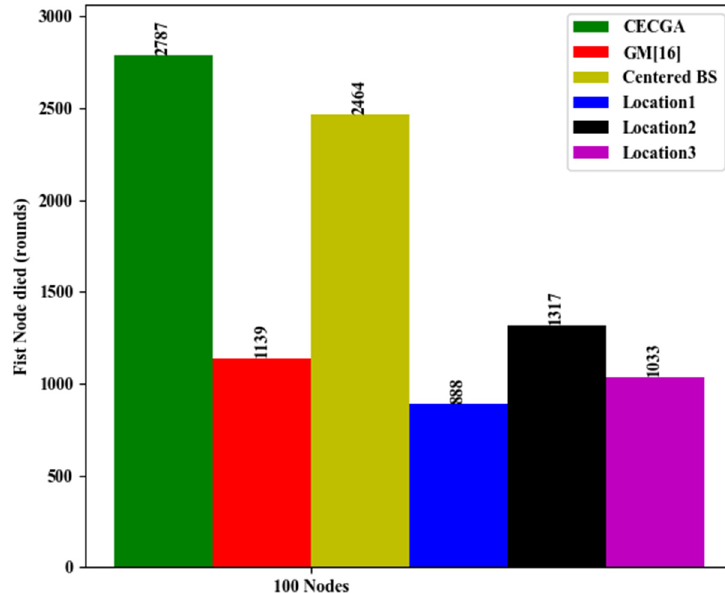
Figure 11. First node death.